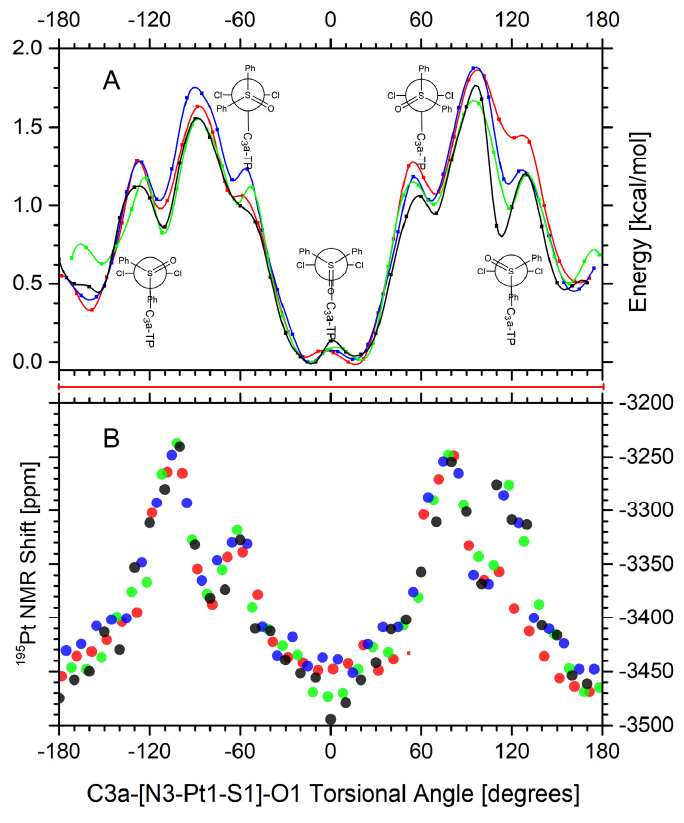
Figure 6. Calculated scan of the potential energy surface (panel ( A )) and 195 Pt NMR shifts (panel ( B )) as a function of the (C3a)-Pt1-S1 = O1 torsional angle for trans -isomers of dmtp ( black ), dbtp ( blue ), ibmtp ( green ), and dptp ( red ). A red bar between the panels indicates a degree of rotational freedom within about 2 kcal/mol above the rotational energy minimum (complete 360-degree rotation). See a table in the supplementary material for values used in the